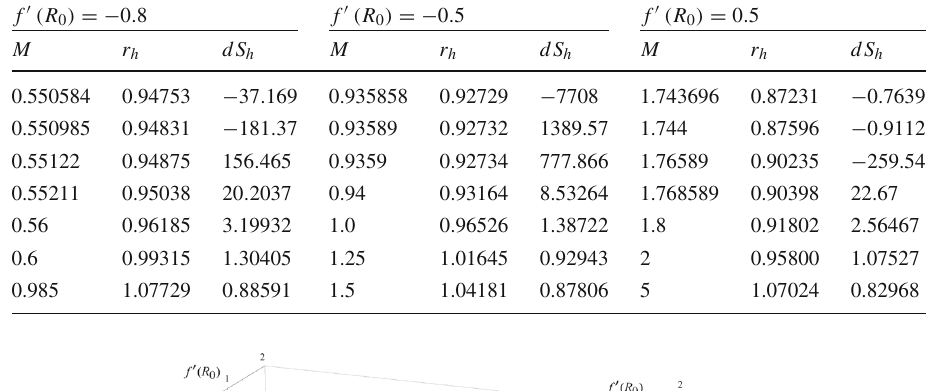
Table 6 The relation between dS h , M and r h of p =